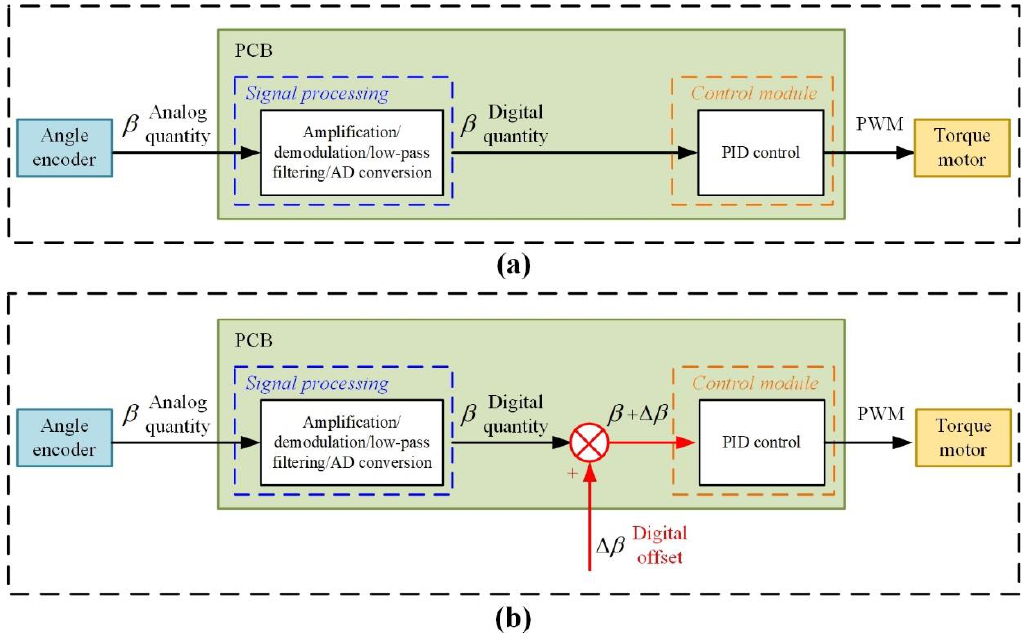
Figure 6. ( a ) Traditional servo control method for angle β ; ( a ) proposed servo control method for angle β based on digital offset.